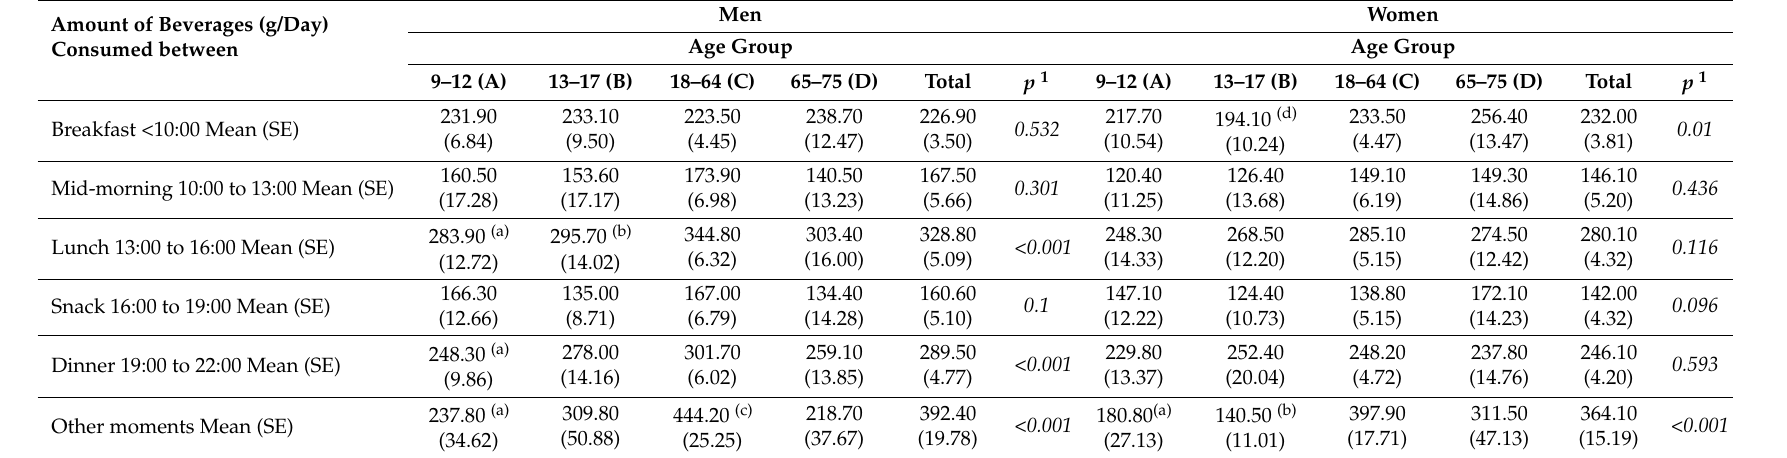
Table 5. Beverage consumption according to time of day (hour interval), by age and